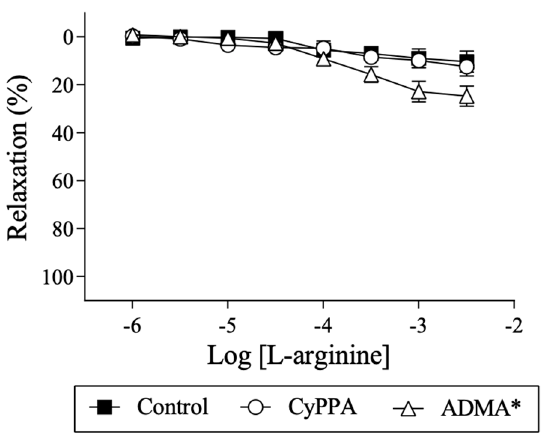
Figure A1. l -arginine-induced relaxation in the absence and presence of CyPPA (6 µ M), an opener of SKCa2 and SKCa3 channels, or ADMA (300 µ M), an inhibitor of NO synthase, in U46619-contracted porcine retinal arterioles. Data are means ± S.E.M. ( n = 5–7). Two-way ANOVA. * p < 0.05 vs .